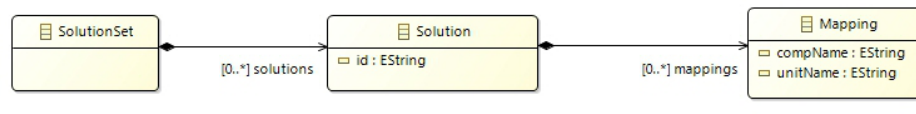
Figure 5. The solution set